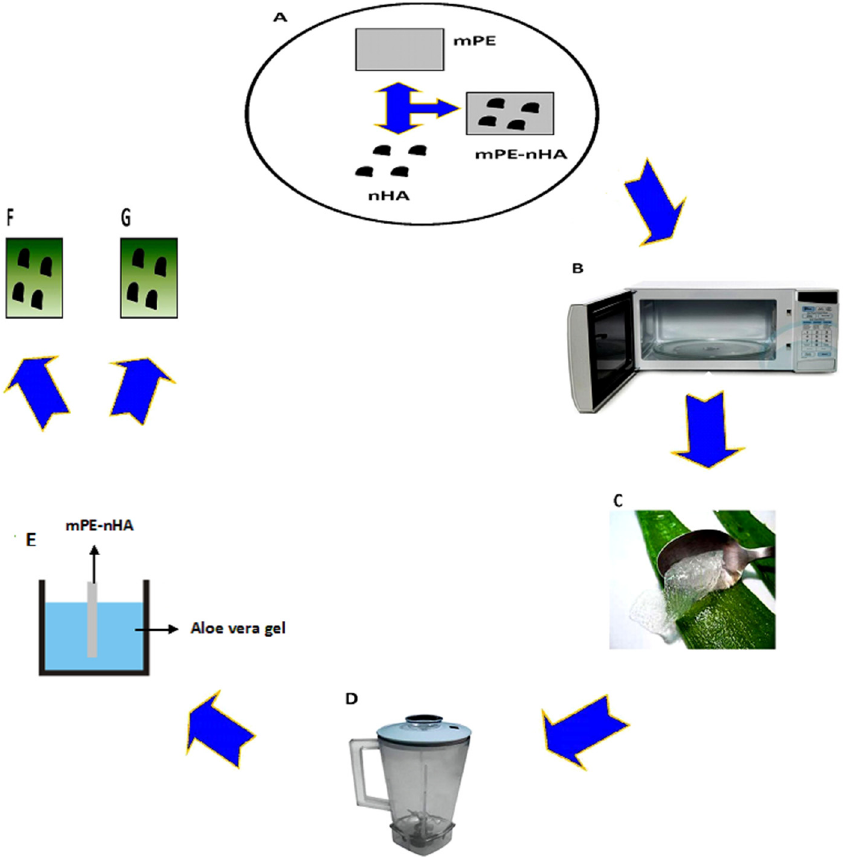
Figure 1. Schematic representation of steps involved in mPE ‐ nHA nanocomposite coating with Aloe vera . ( A ) Synthesis of mPE ‐ nHA nanocomposite; ( B ) 60 s microwave treatment; ( C ) Extraction of Aloe